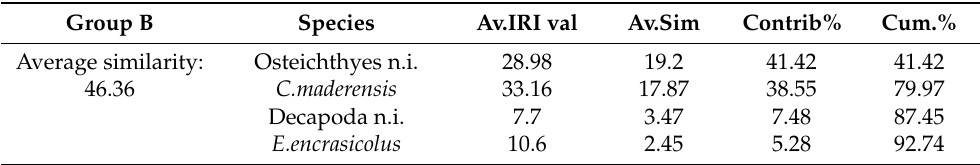
Table 4. Results of the SIMPER analysis conducted between European hake trophic groups from 2018. The average similarity between cluster groups is reported. The percentage and cumulative contribution of typifying species within-group similarity of the identified hake trophic groups is shown. The table shows results obtained for the trophic cluster B, which includes Classes II–IV. Trophic cluster A = less than 2 size